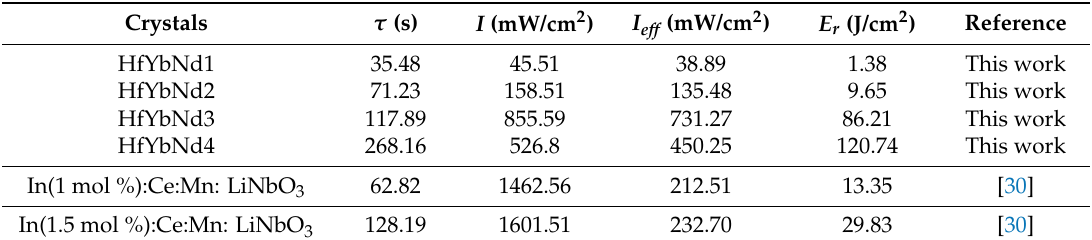
Table 3. Light-induced scattering parameters of Hf:Yb:Nd:LiNbO 3 crystals, illumination light